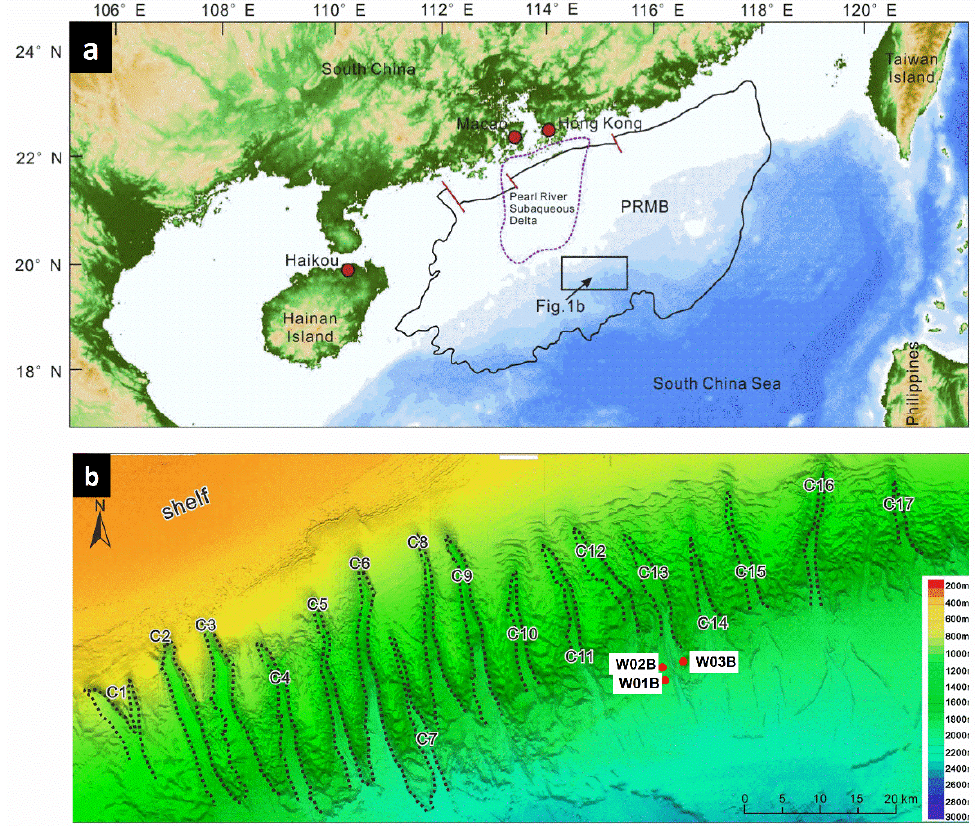
Figure 1. ( a ) Location of the Shenhu area in the Baiyun Sag of the Pearl River Mouth Basin (PRMB), South China Sea (SCS), modified from [24]; ( b ) location of the hydrate coring sites of this study—W01B, W02B, and W03B. C1–C17 refer to 17 canyons in the Shenhu area, modified from